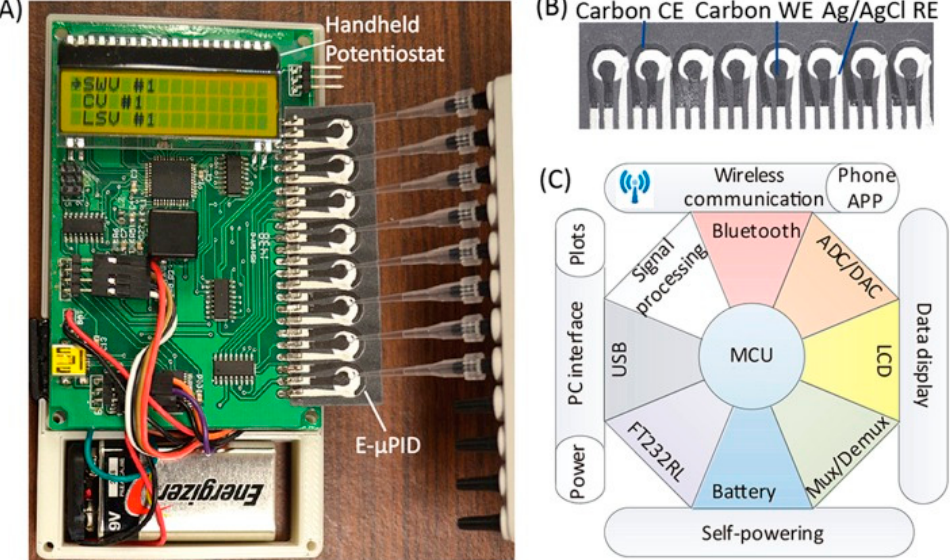
Figure 3. A portable paper-based diagnostic platform integrating an electrochemical microfluidic paper-based immunosensor array (E-µPIA) and a handheld potentiostat. ( A ) The handheld potentiostat inserted with an E-µPIA. ( B ) The E-µPIA. ( C ) Schematic architecture of the potentiostat circuit constructed based on a microcontroller unit (MCU). Reprinted with permission from ref. [99]. Copyright 2022, AIP Publishing LLC.